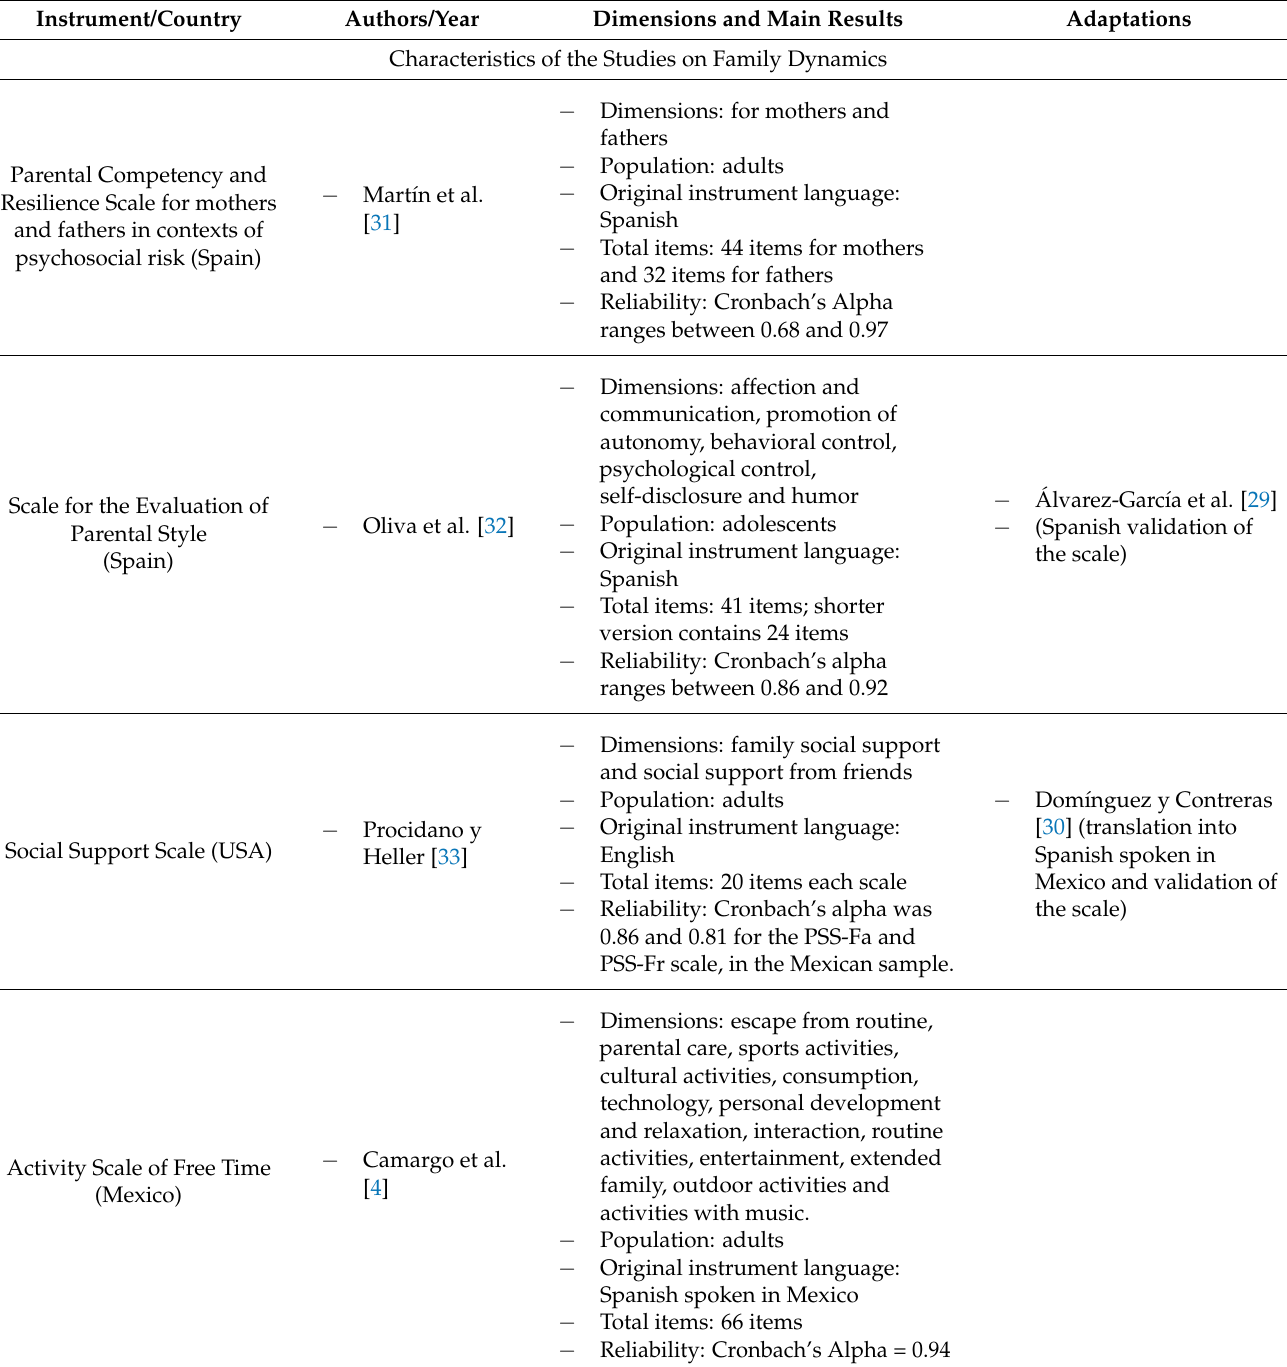
Table 1. Characteristics of the included studies and main